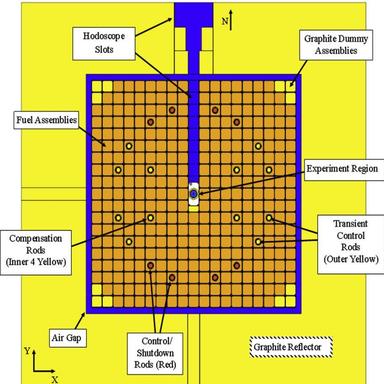
Horizontal Mid-Plane Plot of TREAT Half-Slotted Core with BUSTER in the Experiment Slot.